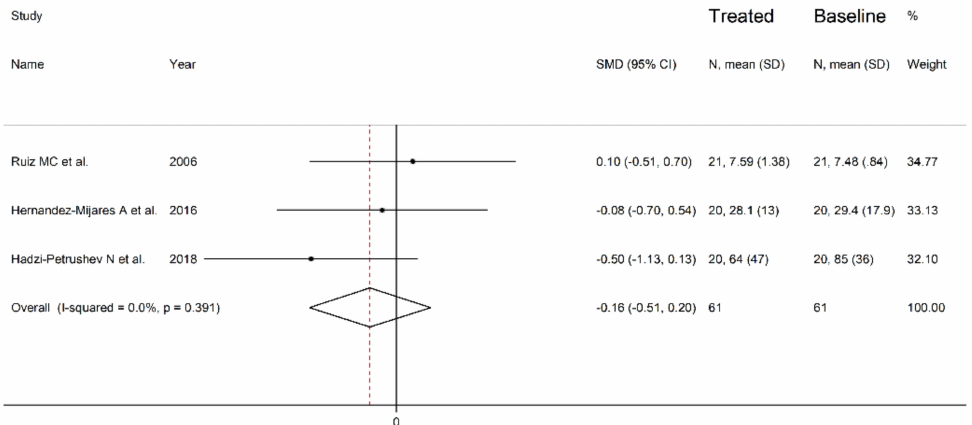
Figure 10. Forest plot of catalase concentrations before and after statin treatment.